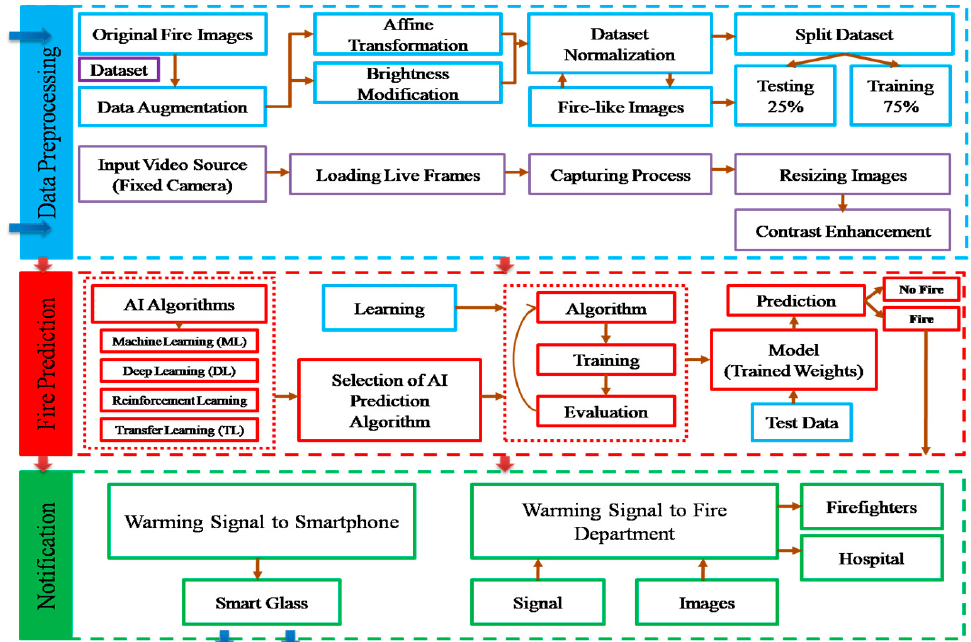
Figure 2. Modular representation of fire detection and classification.